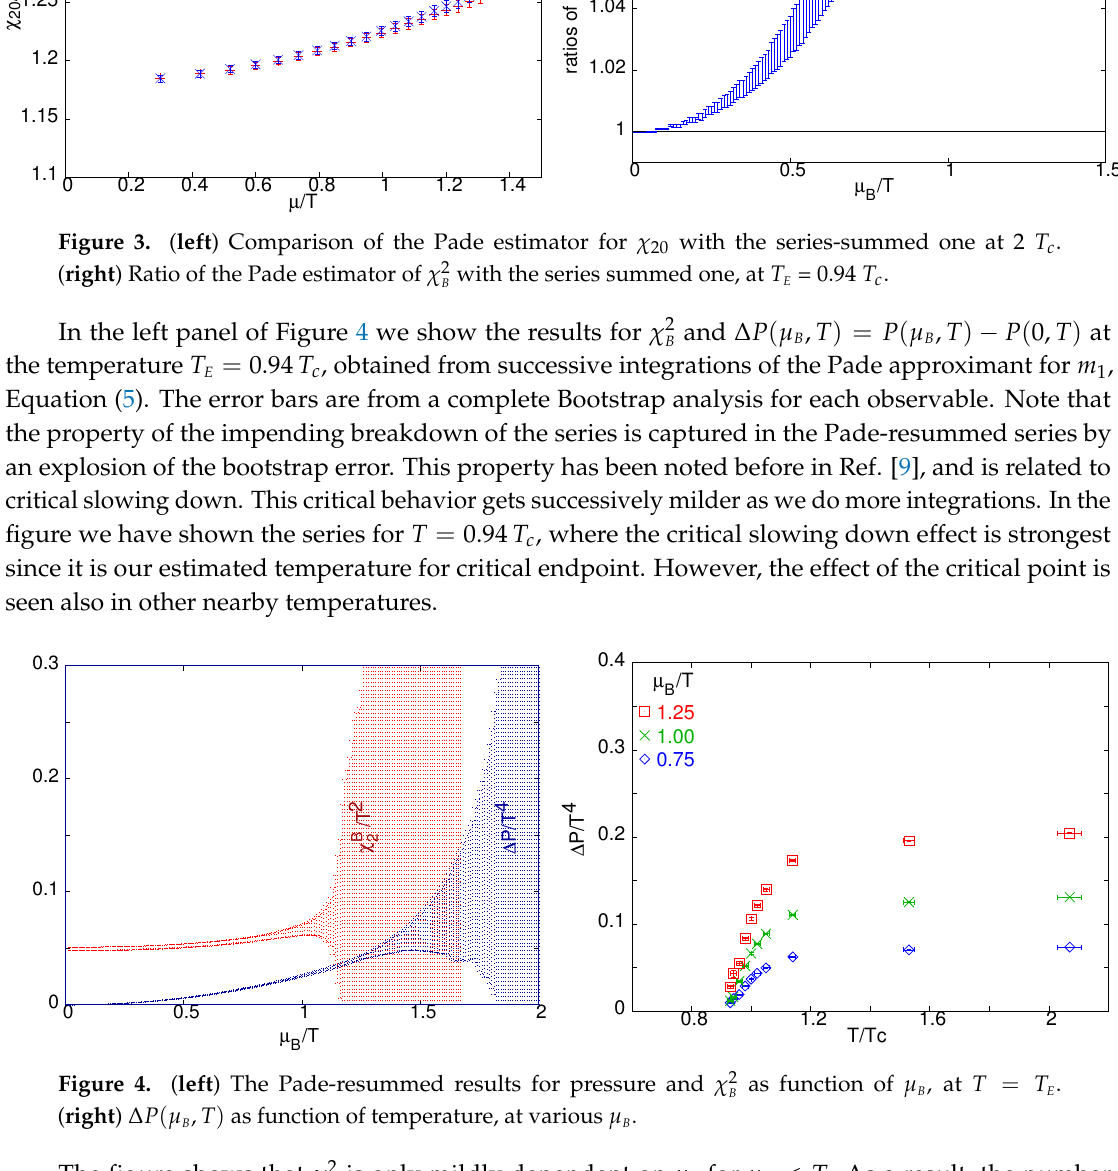
as function of µ B B